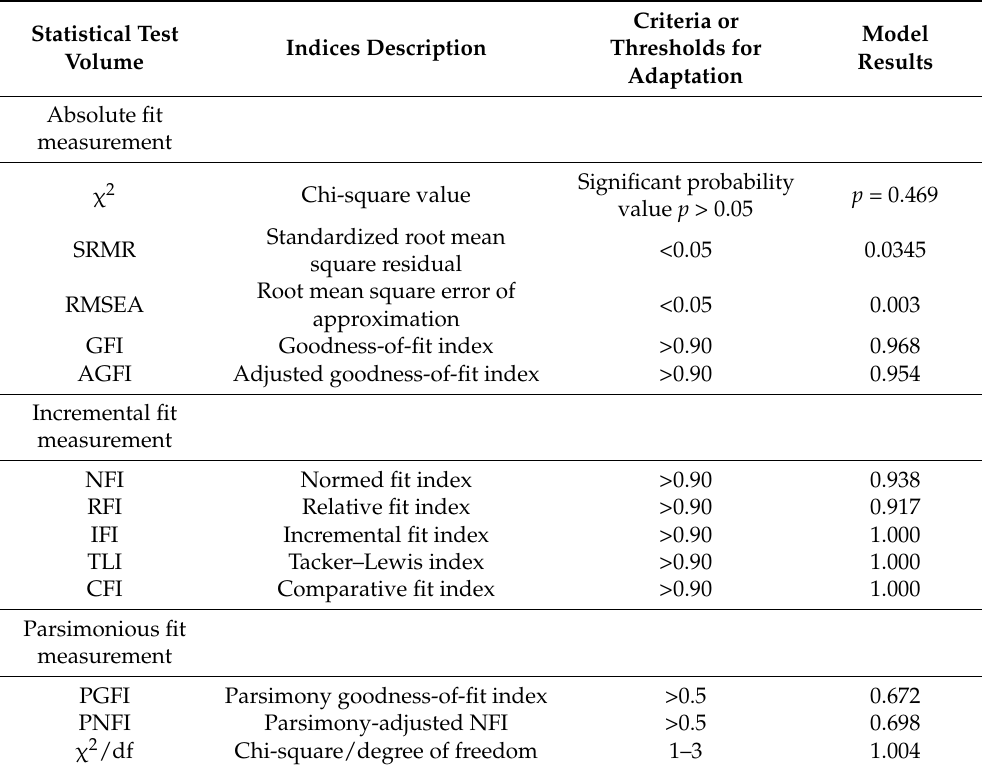
Table 9. Model fitness